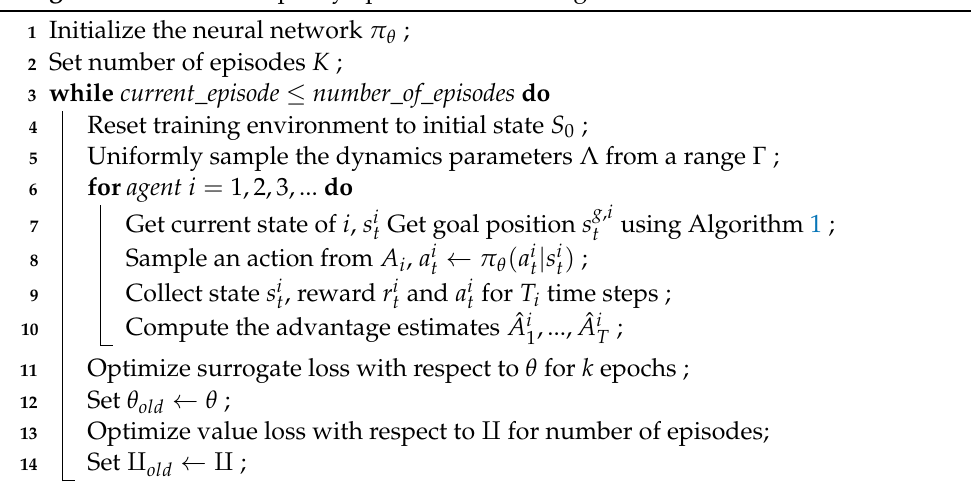
Algorithm 2: Proximal policy optimization